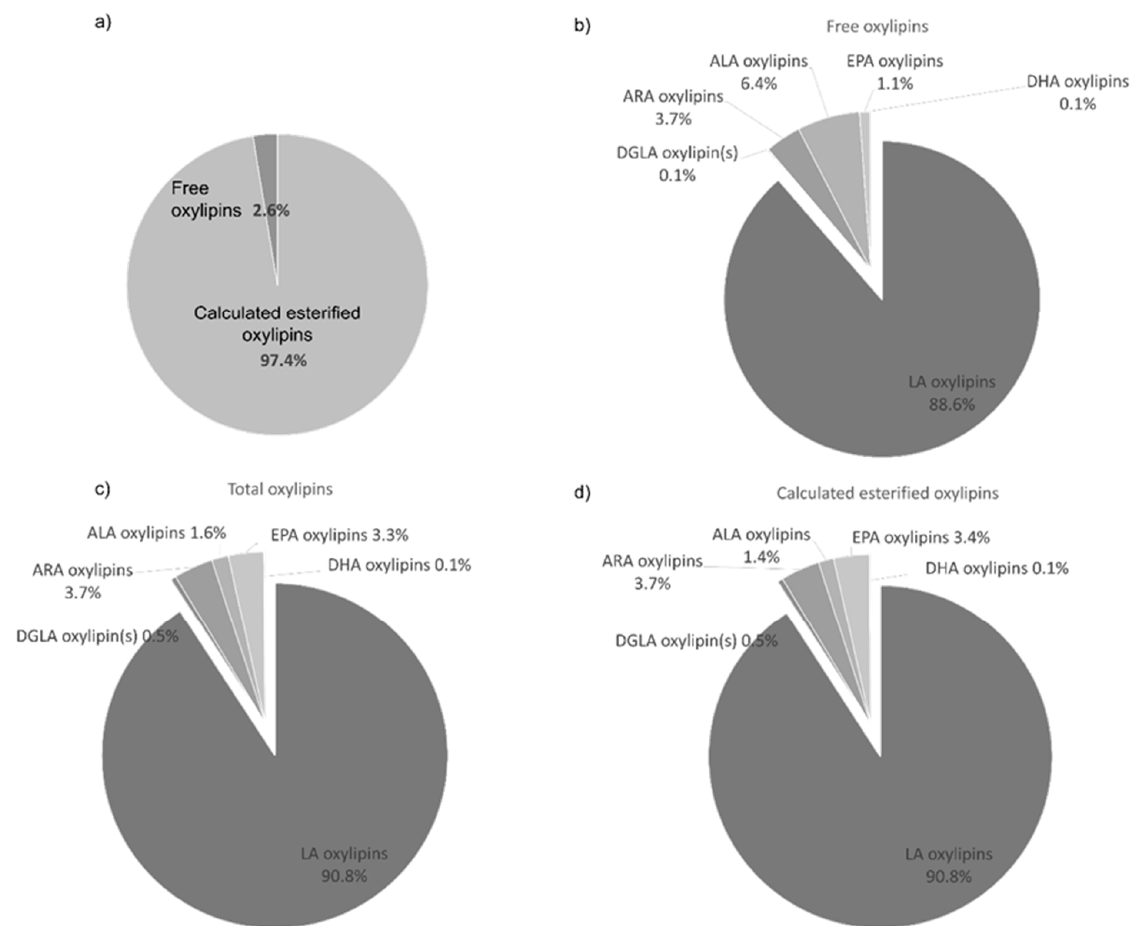
Figure 8. Phospholipid fraction distribution (calculated based on fatty acid composition per each fraction).